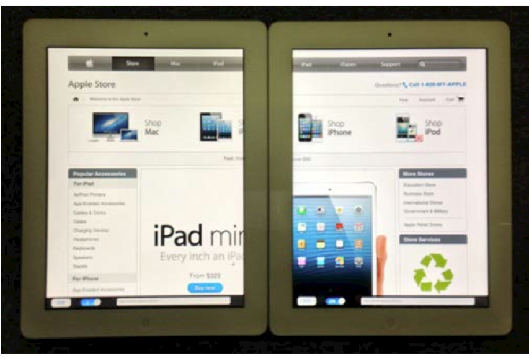
Fig. 1. Example of an extended Web displaying